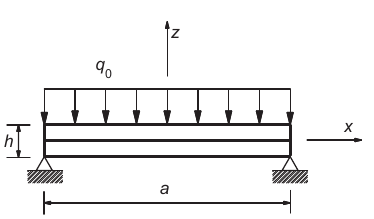
Figure 8 Geometry of laminated composite plate subjected to the distributed load.